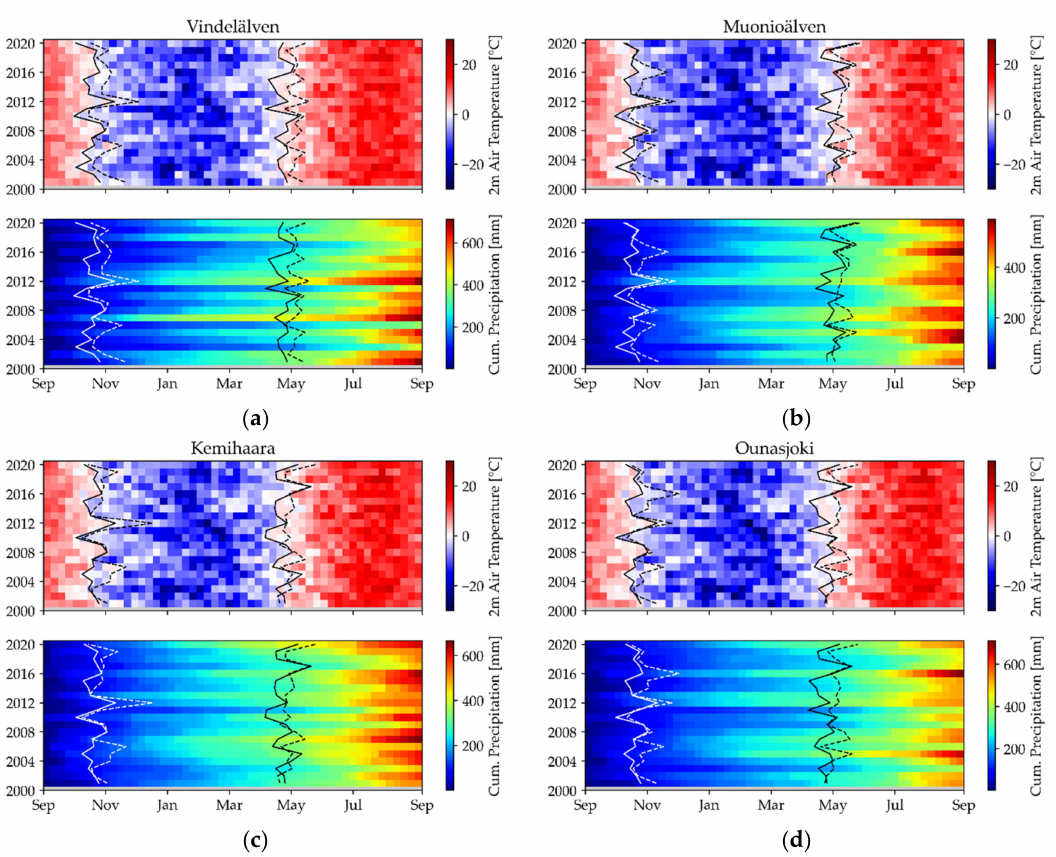
Figure 11. Weekly mean air temperature and weekly sum of precipitation for ( a ) Vindelälven, ( b ) Mounioälven, ( c ) Kemi- haara, and ( d ) Ounasjoki. The earlier lines show the snow cover start, the later the beginning of snowmelt. Solid lines are derived from the satellite product; dashed are derived from the air